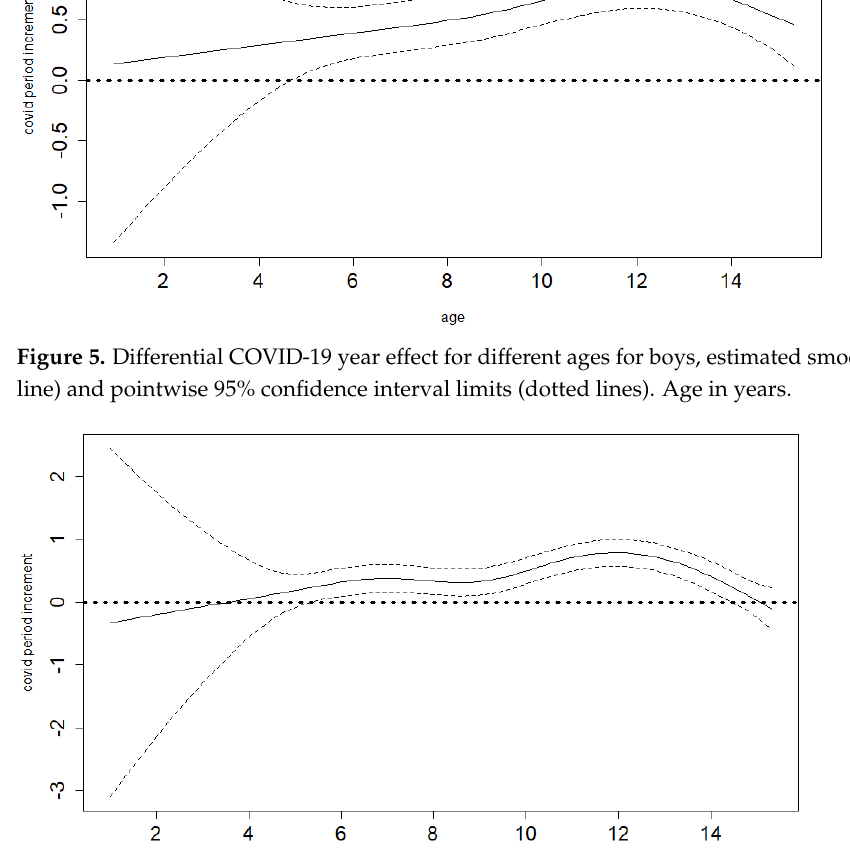
Figure 6. Differential COVID-19-year effect for different ages in girls, estimated smooth trend (solid line) and pointwise 95% confidence interval limits (dotted lines). Age in years.